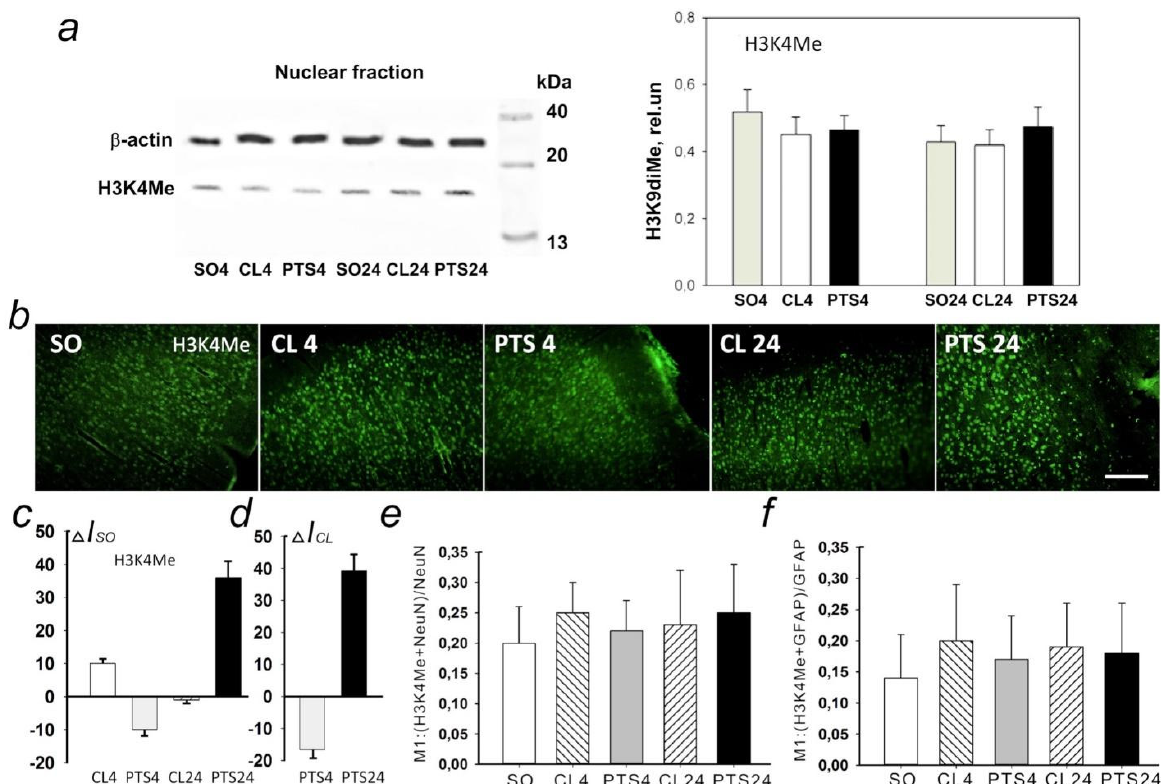
Figure 11. Expression of histone H3 monomethylated for lysine 4 (H3K4Me) in the penumbra and control samples of the cerebral cortex of sham-operated rats (SO) or cerebral cortex in the contralateral hemisphere of the same animal (CL4 and CL24) 4 and 24 h after photothrombotic stroke in the right hemisphere of the rat brain (PTS4 and PTS24). ( a ) Western blotting of H3K4Me in the nuclear fraction of rat brain tissue. One Way ANOVA; M ± SEM, n = 8. ( b ) Immunofluorescence of H3K4Me-positive cells in the cerebral cortex of SO rats, in the unirradiated contralateral cortex (CL4 and CL24) and in the penumbra at PTS4 and PTS24. Scale section: 150 microns. ( c ) Percentage changes in the fluorescence intensity of H3K4me-positive cells in the penumbra and contralateral cortex at PTS4 and PTS24 relative to that in SO animals ( Δ Iso). ( d ) Percentage changes in the fluorescence intensity of H3K4Me-positive cells in the penumbra at PTS4 and PTS24 in the rat cerebral cortex relative to the contralateral cortex ( Δ ICL). One Way ANOVA, n = 8. ( e , f ) Average values of the M1 colocalization coefficient reflecting the proportion of pixels with a red signal (cellular marker, NeuN ( e ) or GFAP ( f )), containing a green signal ( Н 3 К 4 Ме ), in relation to the common signal from the red channel. M ± SEM, ANOVA, n = 8; Rel.un—the ratio of the optical density of the strip of the protein studied to the optical density of the strip of the protein load marker (actin).